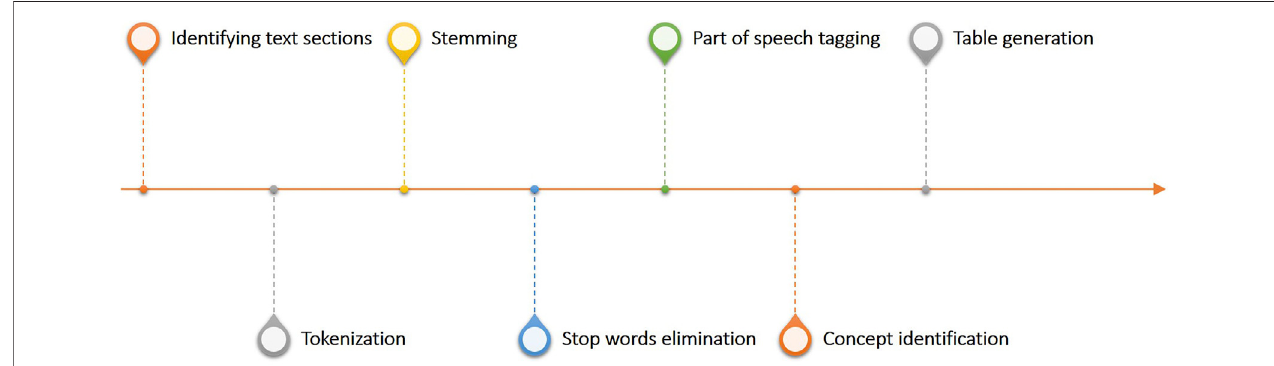
FIGURE 7 | Overview of the text analytics work fl ow linked to the generator infrastructure and used to process and structure free text reports.